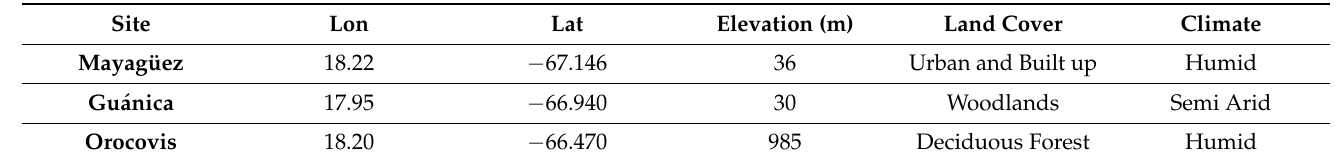
Table 4. Conditions at the three ET a comparison sites.